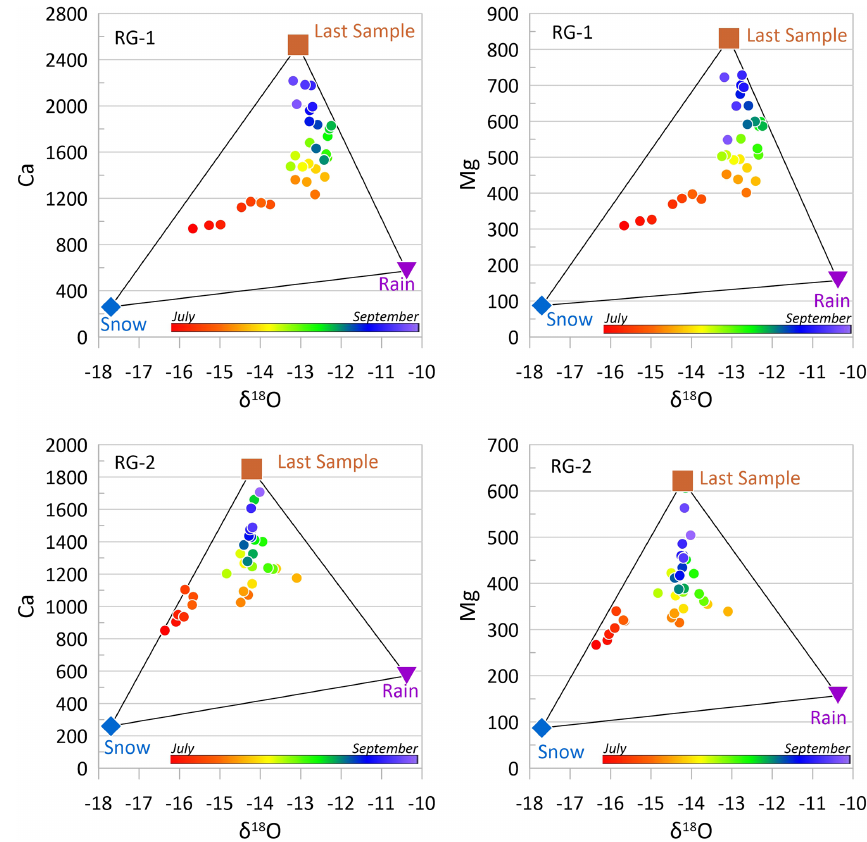
Figure 10. Biplots of δ 18 O vs. Ca and Mg at RG-1 and RG-2. Circles represent water discharging from the rock glacier springs, with the rainbow pattern progressing from early July (red) through to early October (purple). The last sample collected at each rock glacier is plotted as the brown square, along with average values for snow and rain. Rock glacier water clearly evolves through the season from a composition dominated by snowmelt, to a mixture of rain and internal water, with decreasing rain influence over